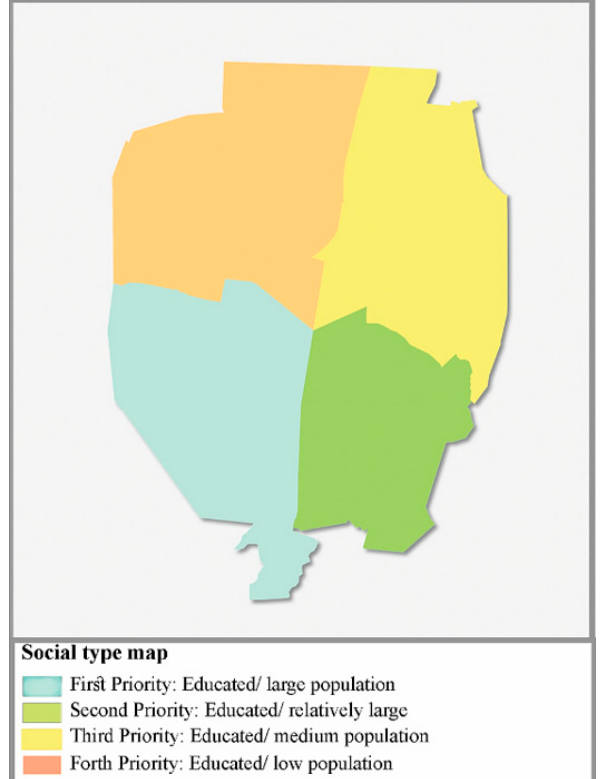
Figure 14. The social type map of Hamedan based on the sub-criteria measures in Table 1.